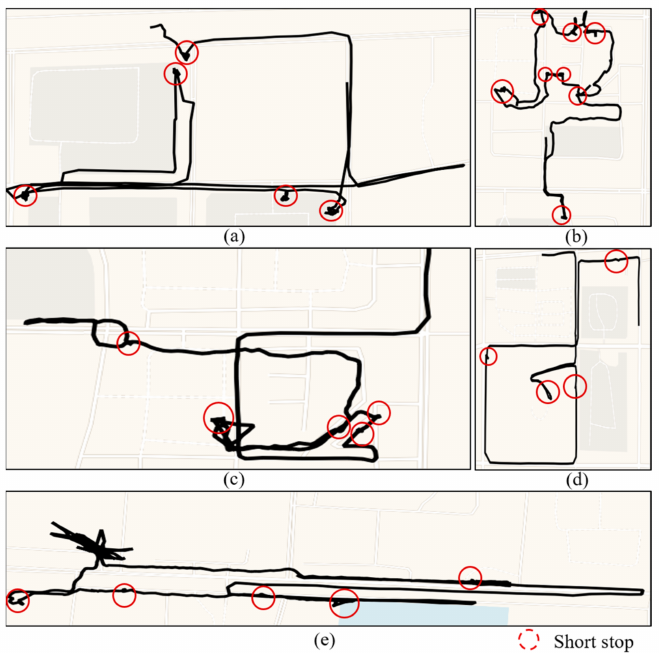
Figure 12. Examples of frequent short stops that were detected from the TucityLife dataset. ( a – e ) Sev- eral trajectories with multiple short stops (red circle) occurring within a short